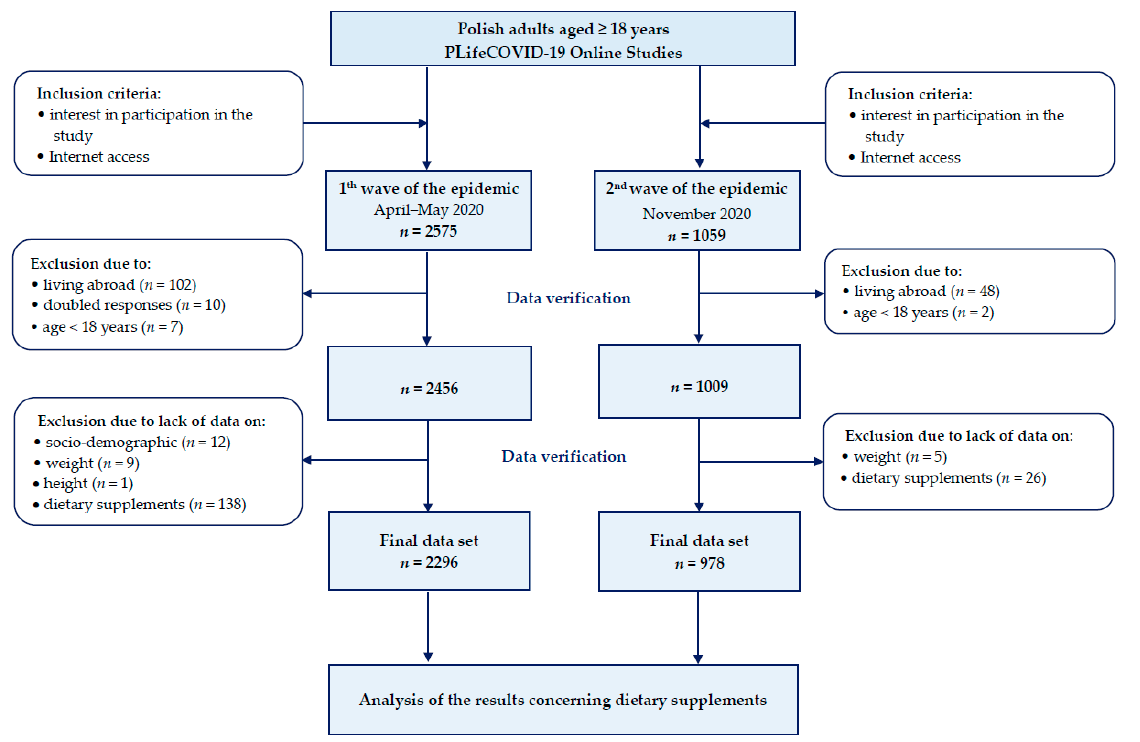
Figure 1. Flowchart of the creation of the final data set from participants of the PLifeCOVID-19 Study.